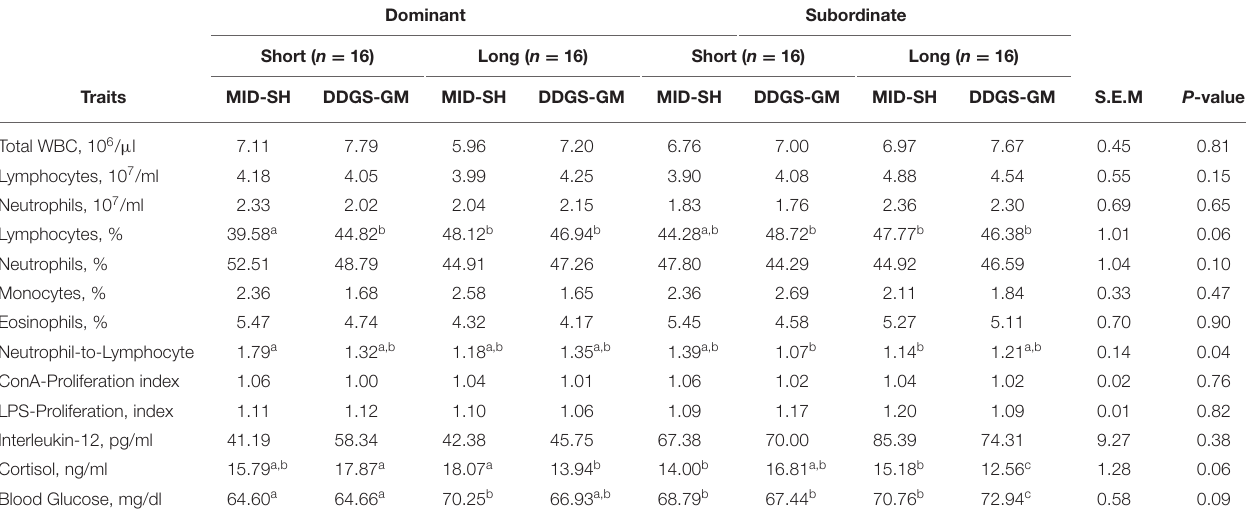
TABLE 7 | Interactive effects of social status, barrier length, and diet on mean immune, cortisol, and glucose measures for pregnant sows housed in small group pens throughout gestation ( n = 64 total sows). Dominant